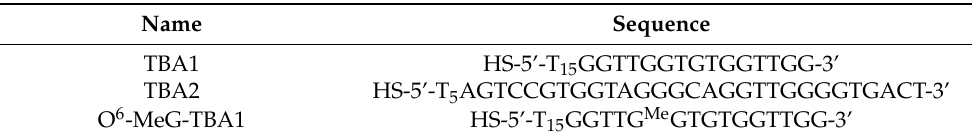
Table 1. Oligonucleotide sequences of the three α -thrombin binding